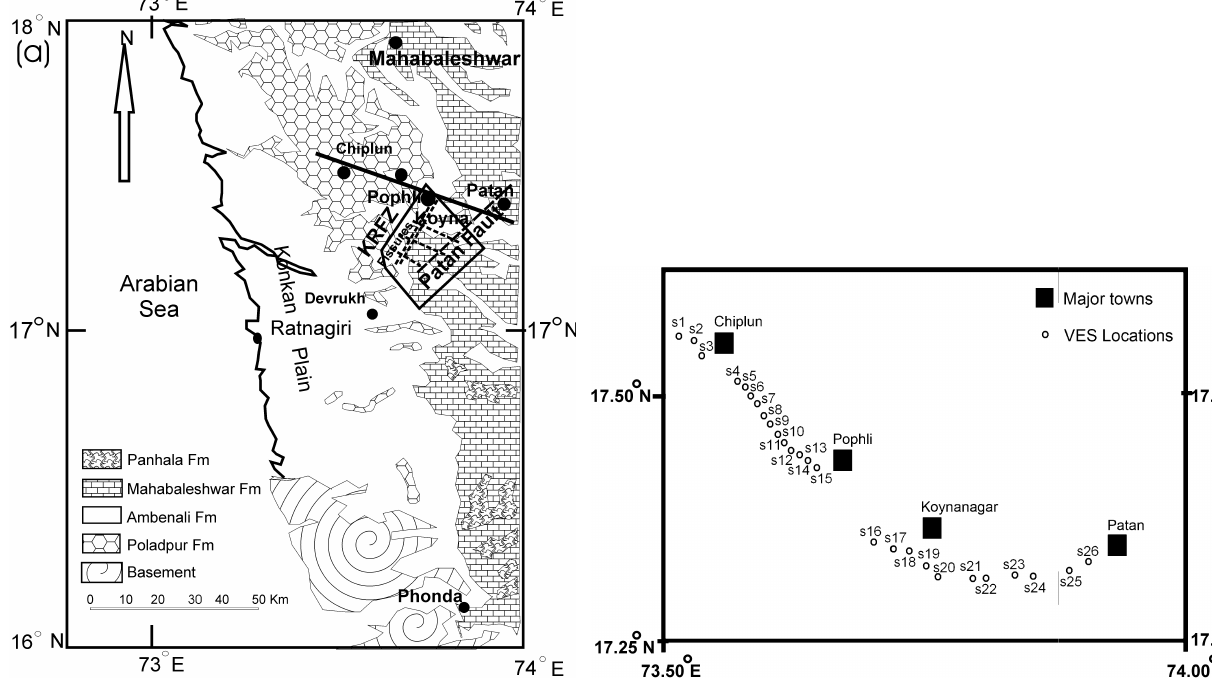
Fig. 1. (a) Geological map of the study area, (b) location map of the Schlumberger resistivity profile.